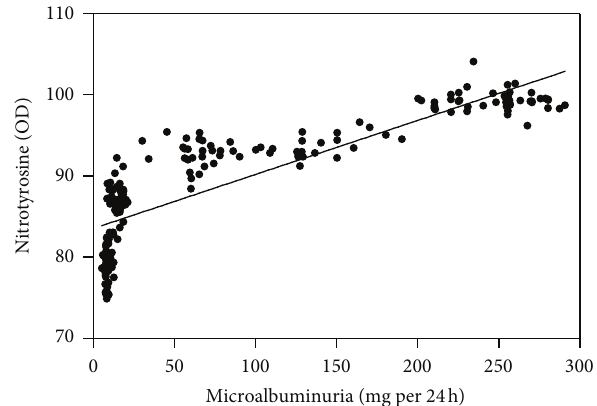
per group). 𝑛𝑛 𝑛 𝑛𝑛